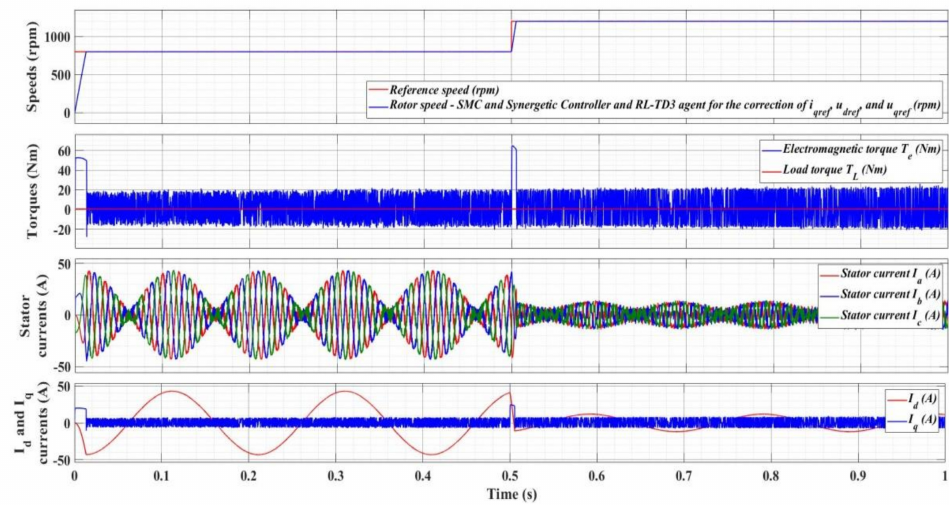
Figure 35. Time evolution for the numerical simulation of the PMSM control system based on control using SMC and synergetic controllers using an RL-TD3 agent for the correction of u dref , u qref , and i qref . The validation of the robustness of the PMSM control system based on SMC and synergetic controllers, and the three variants of control signal correction implemented by means of the RL-TD3 agent, were achieved by modifying the load torque T L and the combined inertia of the PMSM rotor and load J , which are considered to be disturbances.